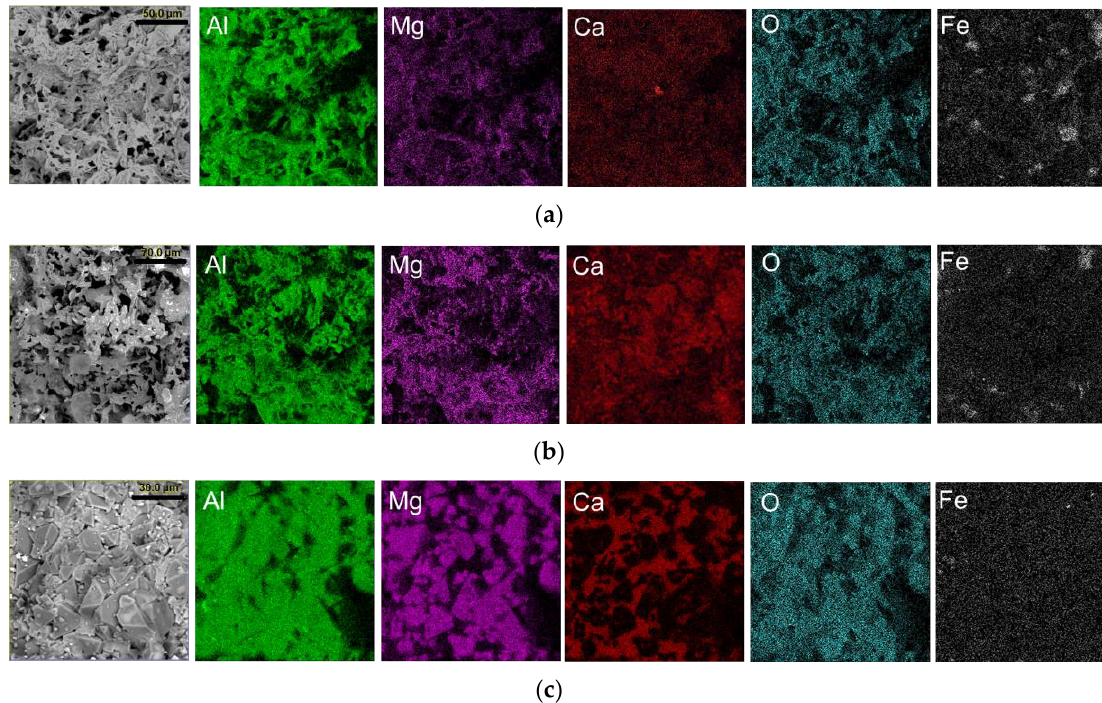
Figure 2. Morphology and composition of clogging materials at various positions of the SEN: ( a ) position 1, ( b ) position 2, ( c ) position 3.